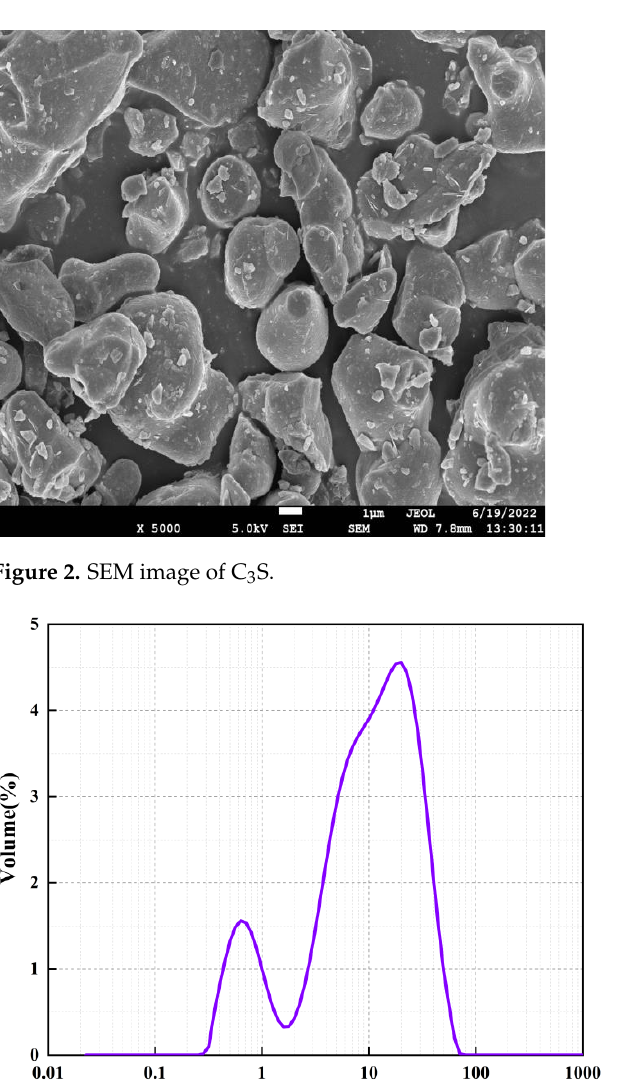
Figure 3. Particle size distribution of tricalcium silicate powder. Table 1. Particle size of C 3